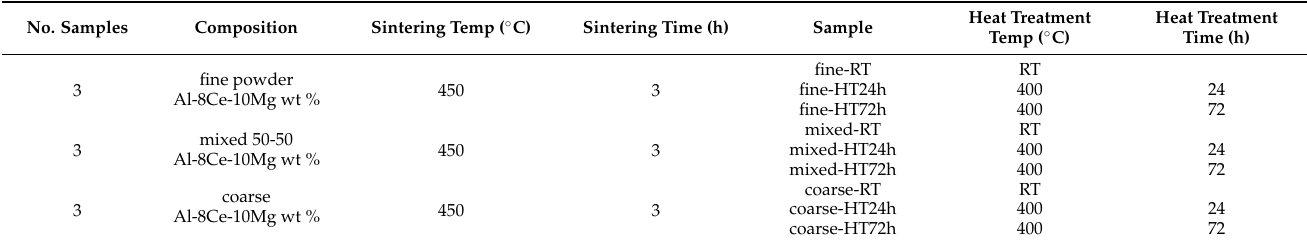
Table A2. Test matrix PIT Al-8Ce-10Mg wt %